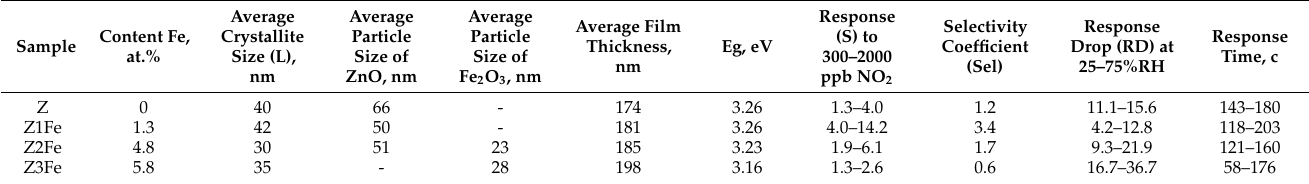
coating. Table 1 summarizes the properties of the obtained ZnO/Fe 2 O 3 nanostructured thin films. Table 1. Various characteristics of the obtained ZnO/Fe 2 O 3 nanostructured thin films.